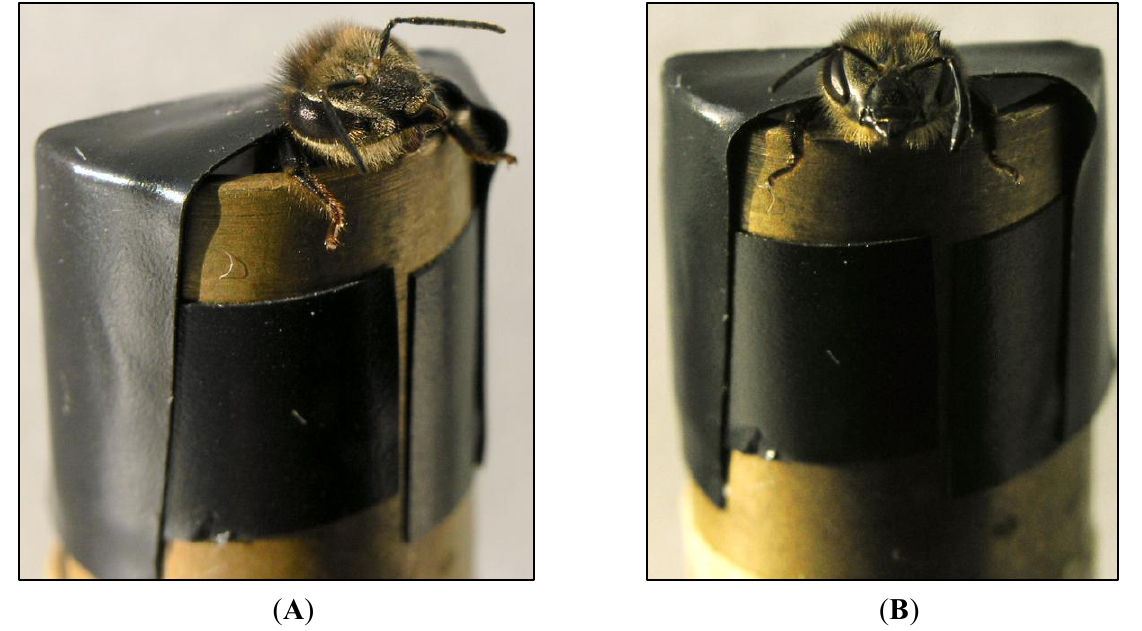
Figure 1. Proboscis Extension Reflex (PER) paradigm. ( A ) Harnessed bee with both antennae in use. ( B ) Harnessed bee with only the right antenna in use (cid:178) the left antenna is coated with a black silicone compound. (Photo by Elisa